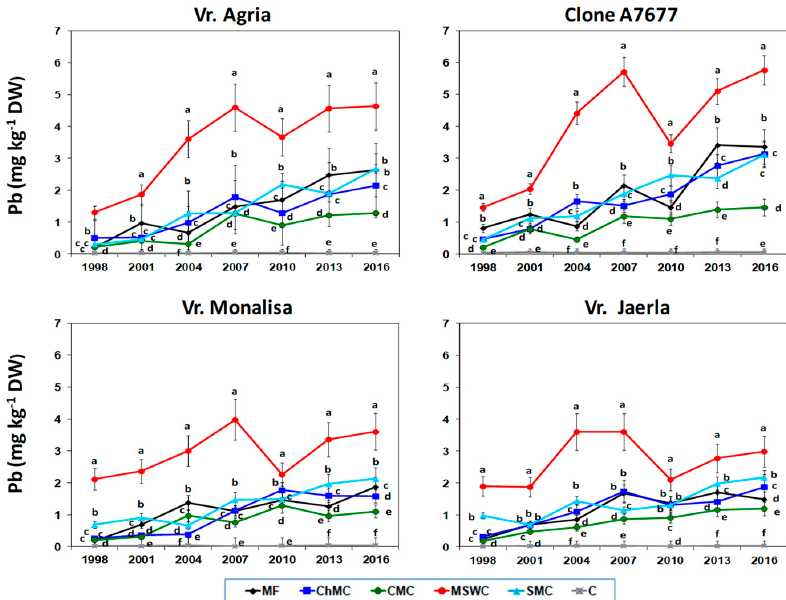
Figure 11. Evolution of lead content (mg kg − 1 DW) in potato tubers of the Agria, Monalisa, Jaerla and clone A7677 varieties (1998–2016) versus the application of compost from di ff erent organic amendments. The means with di ff erent lowercase letters within each season indicate significant di ff erences between the treatments ( p < 0.001). Bars stands for standard deviations. MF: mineral fertilizer; ChMC: chicken manure compost; CMC: cow manure compost; MSWC: municipal solid waste compost; SMC: sheep manure compost; C: